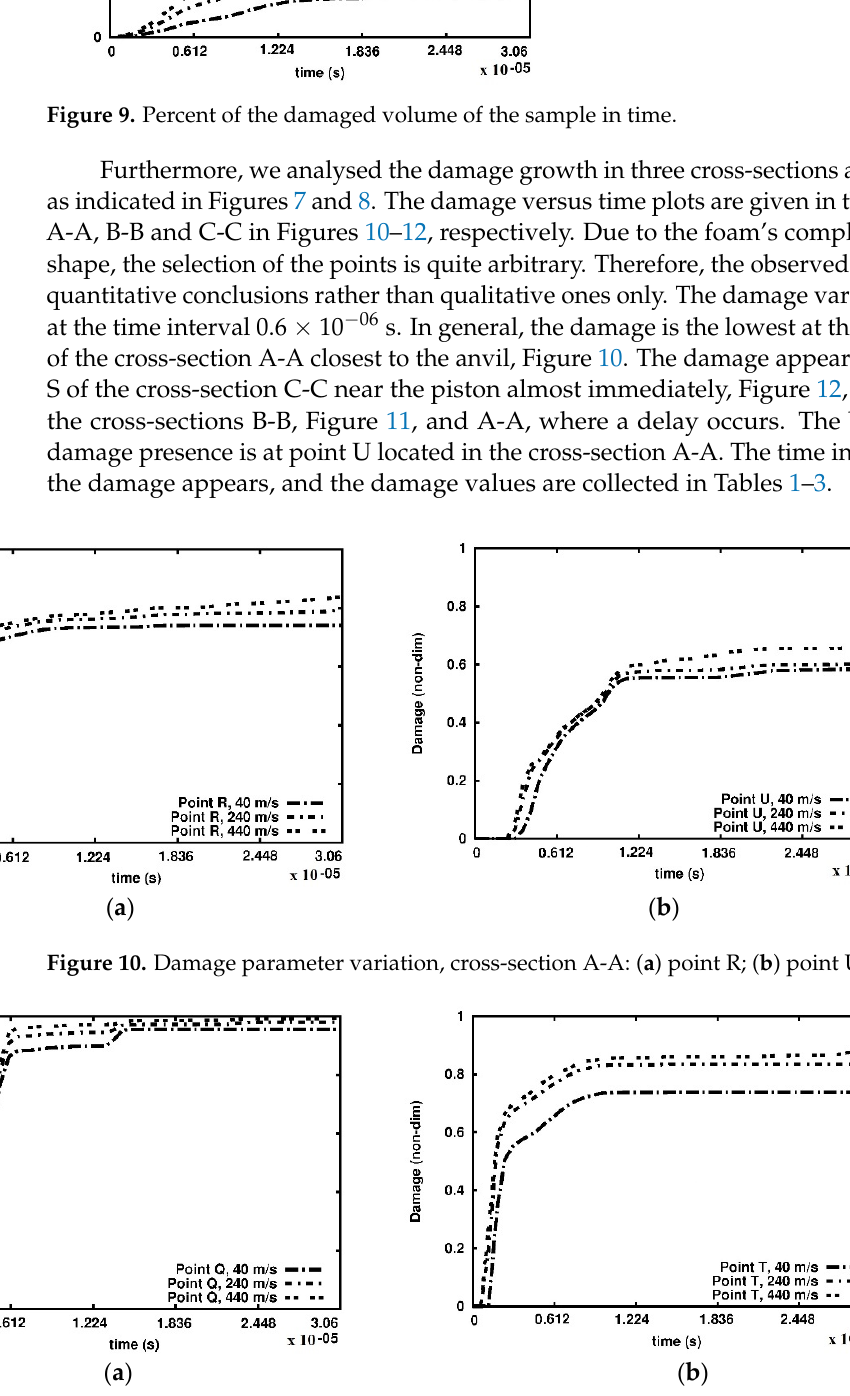
Figure 9. Percent of the damaged volume of the sample in time.